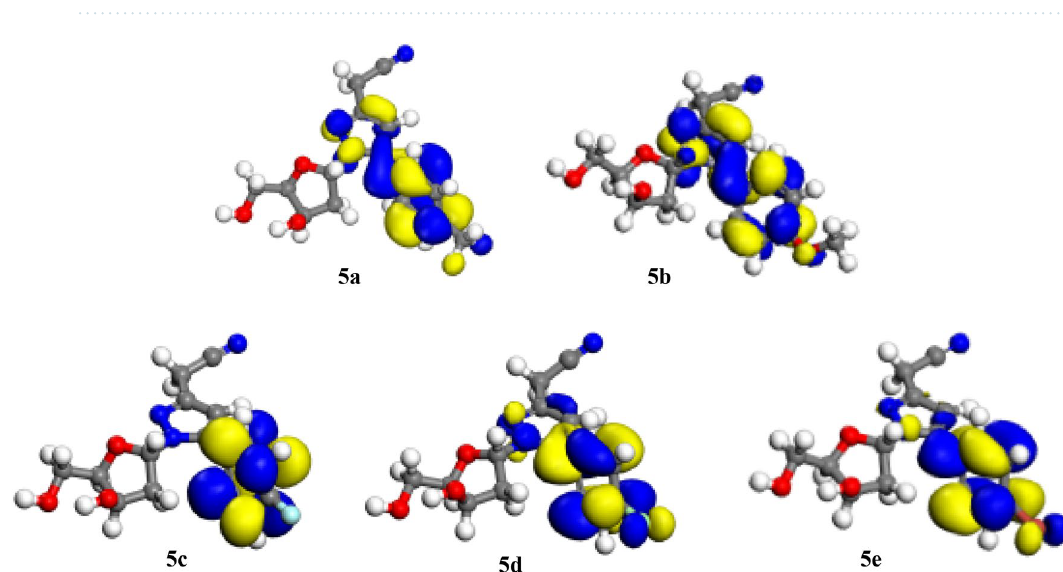
Figure 4. LUMO representations of the pyrazolylnucleosides 5a – e